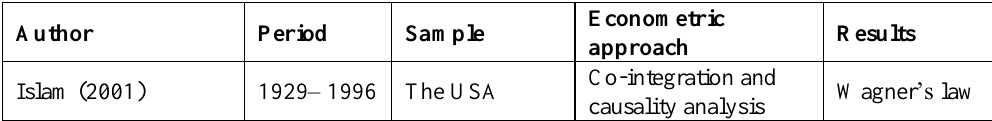
Table 1. Summary of Empirical